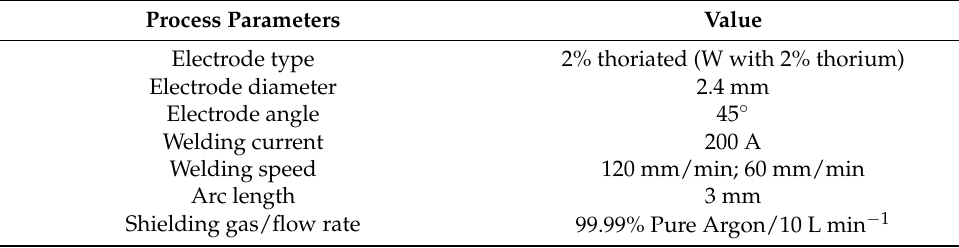
Table 2. Welding parameters used for